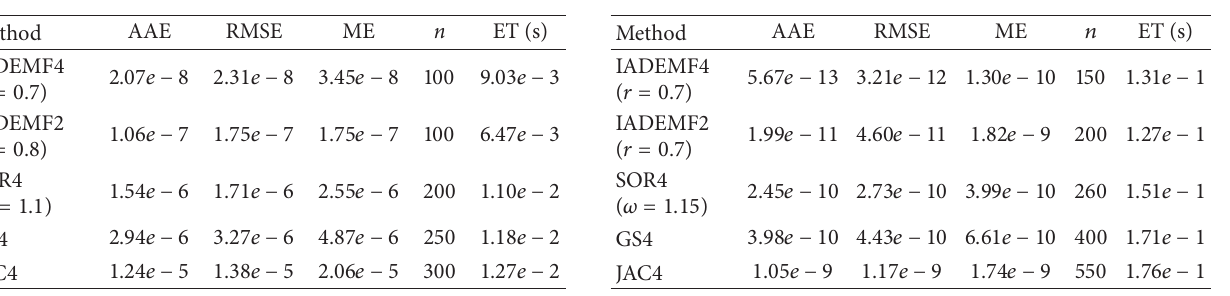
Table 4: Experiment 2. 𝑚 = 700 , 𝜆 = 0.5 , Δ𝑥 = 1.43 × 10 −3 , Δ𝑡 = 1.02 × 10 −6 , 𝑡 = 5.09 × 10 −5 , and 𝜀 = 10 −6 .